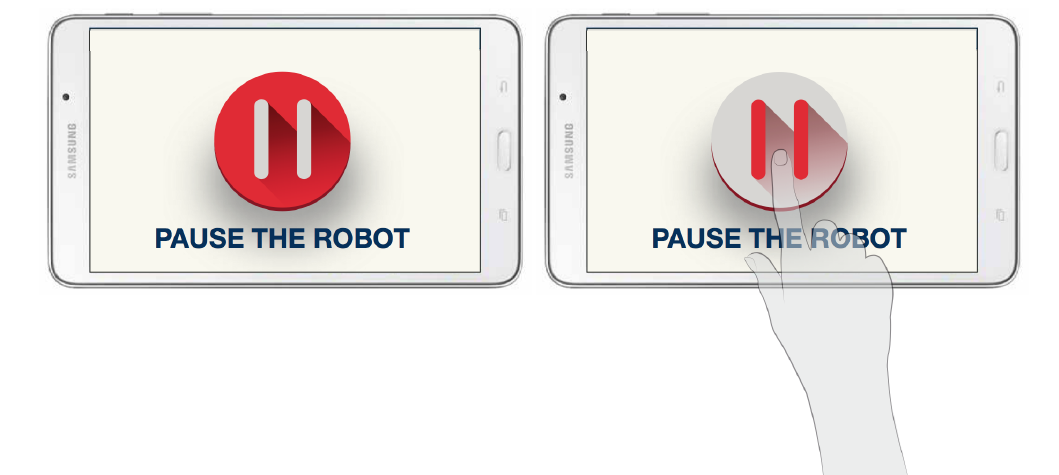
Figure 6. During the navigation, the tablet above the robot provided the option of being momentarily paused and subsequently